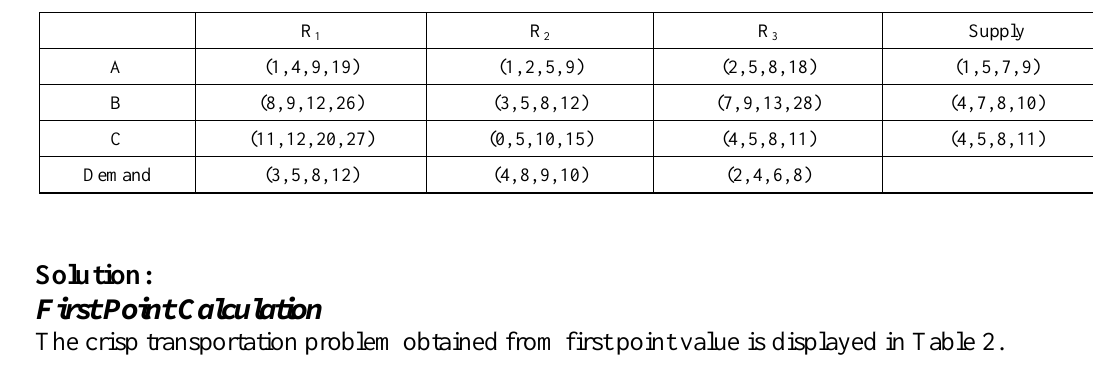
Table 1. FTP in trapezoidal